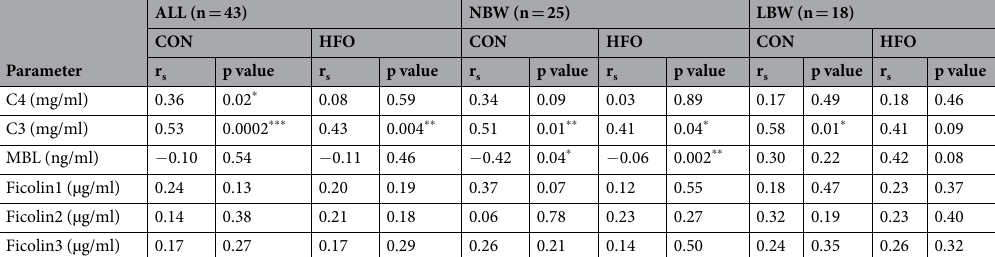
Table 3. Associations between hepatic IR-index and serum levels of C4, C3 and lectin pathway initiators. Spearman’s correlations (r s ) between hepatic IR-index (a measure of hepatic insulin resistance) and serum levels of C4, C3 and lectin pathway initiators. Statistical significance assumed for values * P ≤ 0.05, ** P ≤ 0.01, *** P ≤ 0.001. CON, control diet; HFO, high-fat overfeeding; NBW, normal birth weight individuals; LBW, low